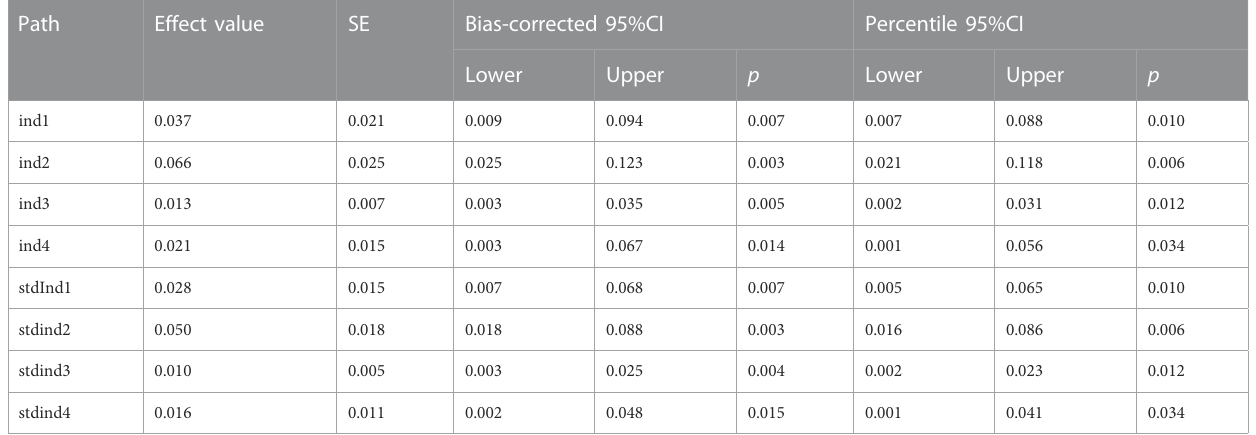
TABLE 5 Bootstrap test of mediating